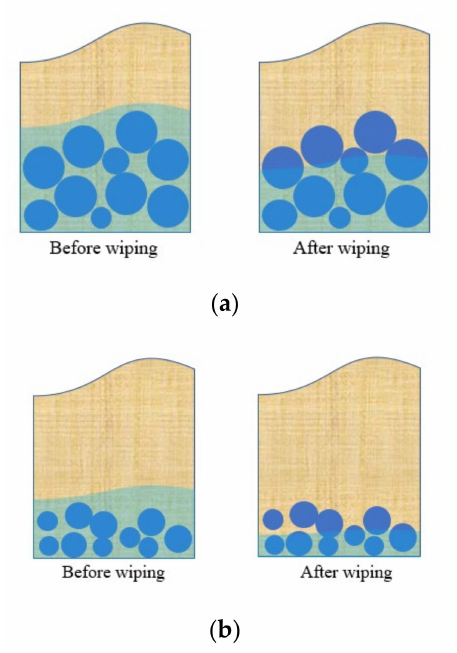
Figure 4. Inter-particle liquid removing process for the tea-bag method: ( a ) SAP A73 with a larger absorptivity and ( b ) SAP N with a lower